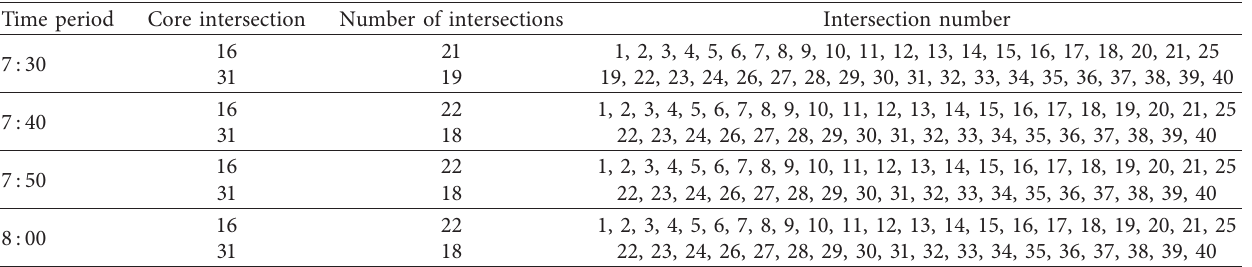
Table 3: Dynamic partition results of the first